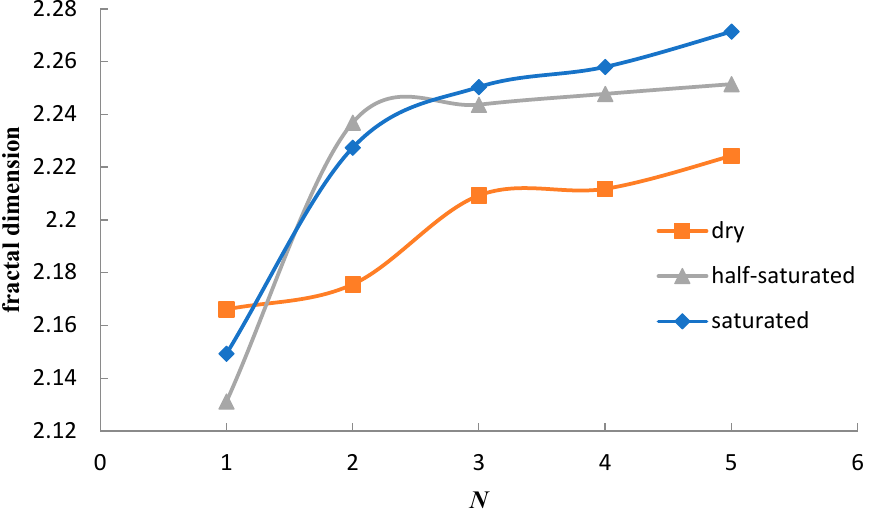
Figure 16. The relationship curve of fractal dimension—impact times.